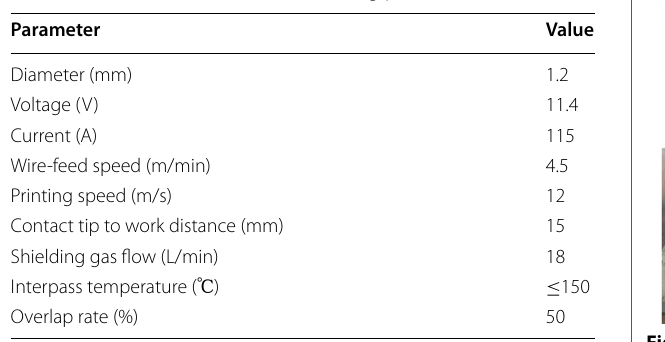
Table 2 Wire arc additive manufacturing